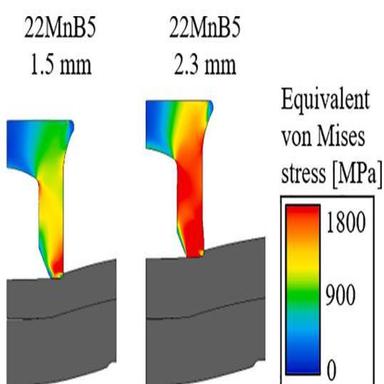
Stress within the rivet before piercing.